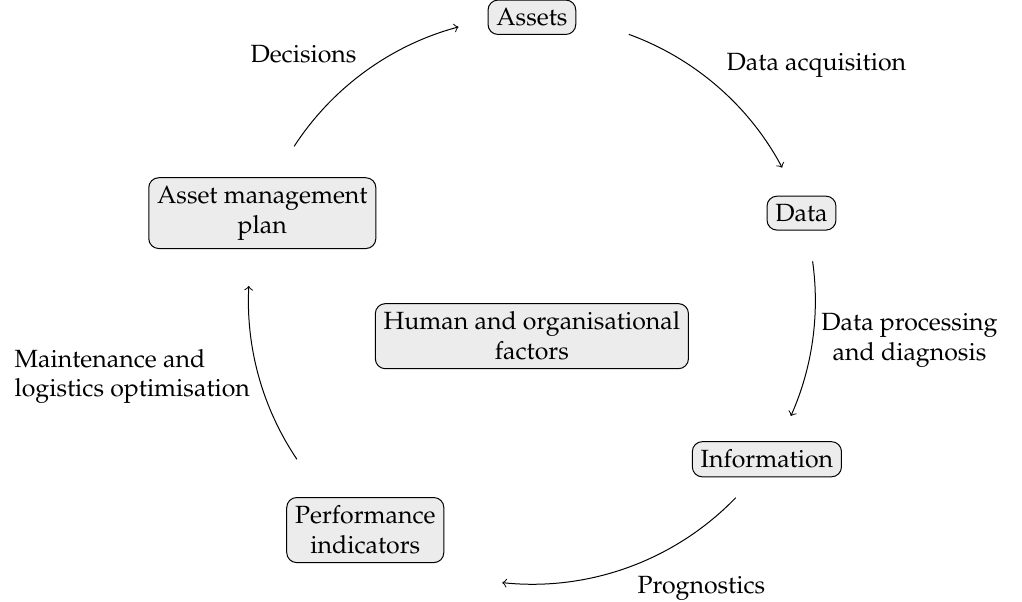
Figure 1. Predictive maintenance management process